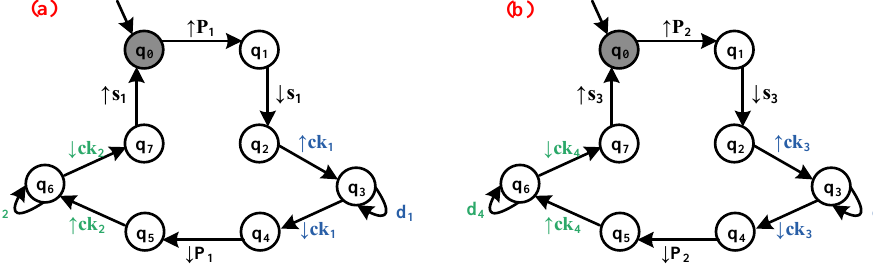
Figure 11. Local controllers LC F . ( a ) P1, ( b ) P2.